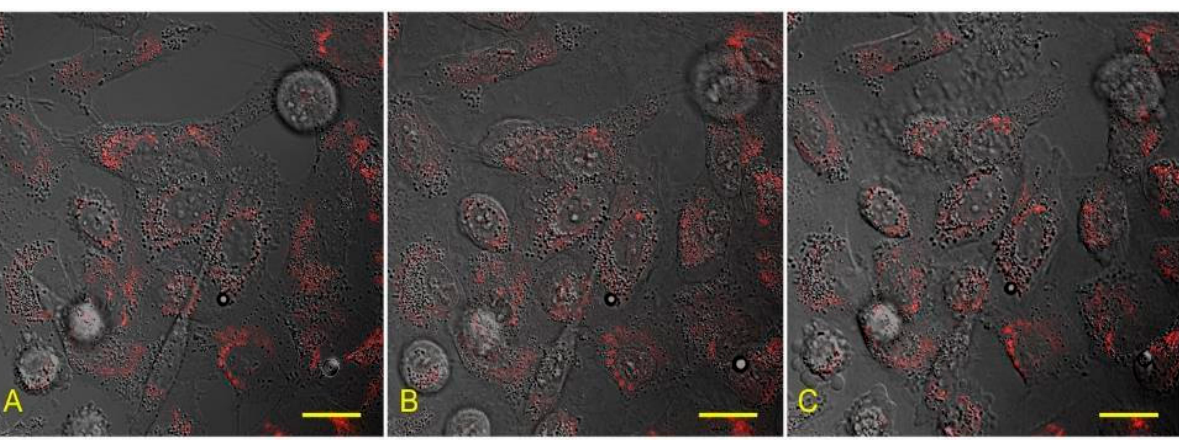
Figure 4. Overlay of the fluorescent (red channel—MitoTracker) and the transmitted light image of the cells before ( A ), during ( B ), and after recovery ( C ) from lanthanoid treatment-induced state. Scale bar: 20 µm.